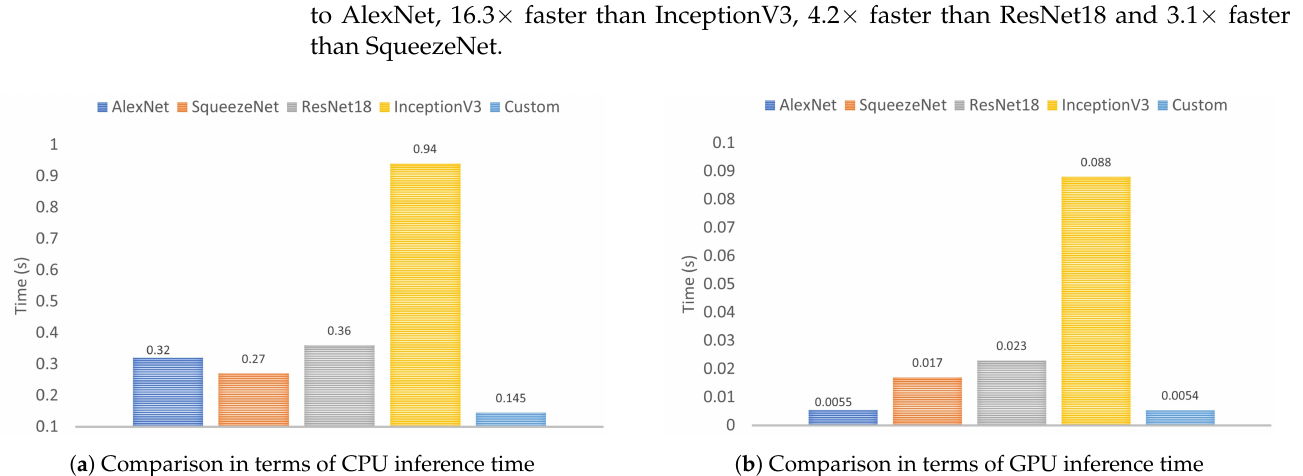
Figure 20. Comparison of the custom model and the four TL-based models in terms of CPU and GPU inference